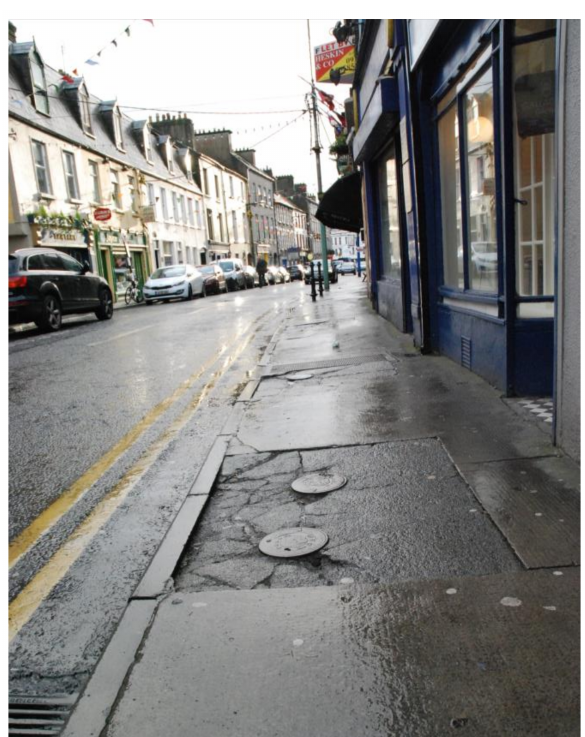
Figure 14. Dominic Street Lower,